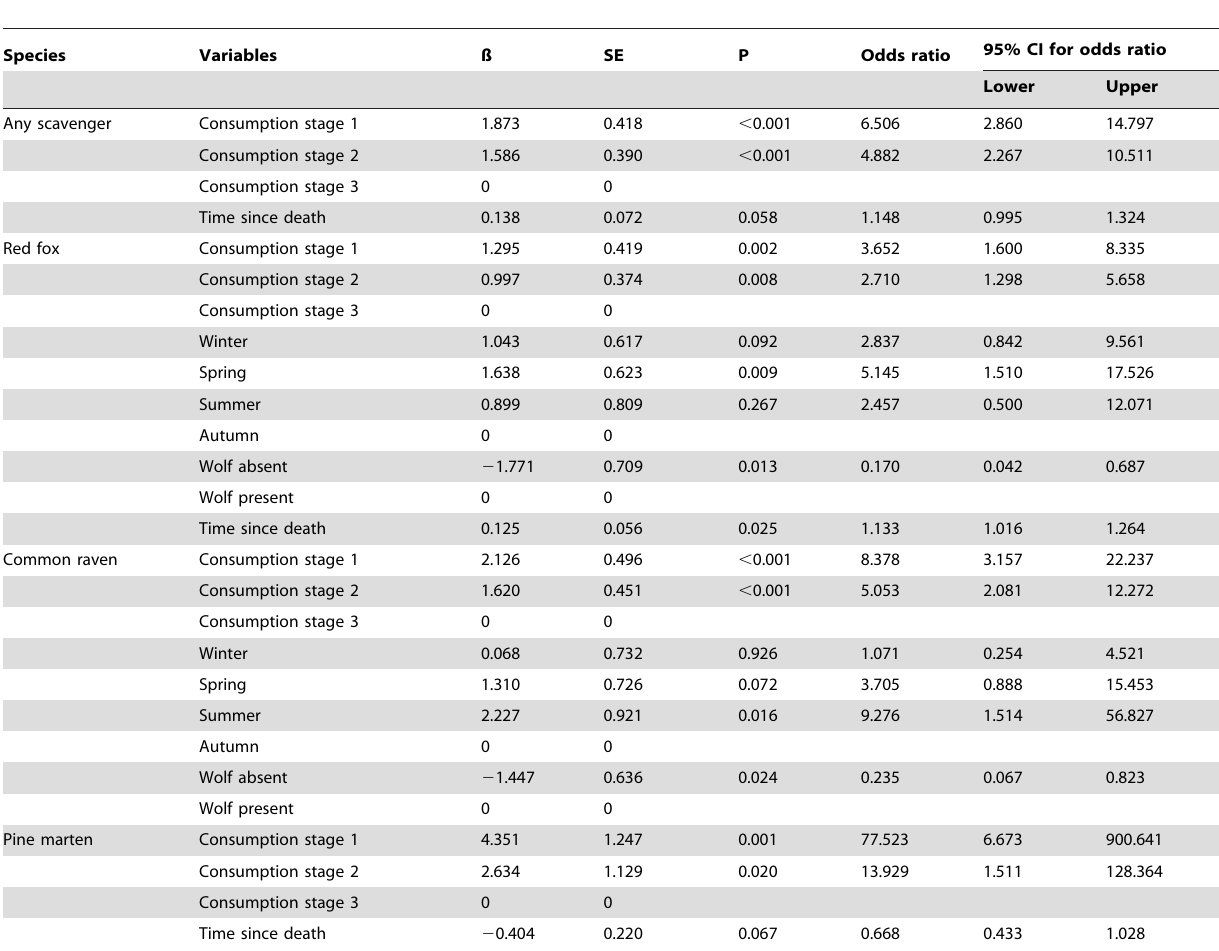
Table 3. Parameter estimates (ß) of consumption stage, season of the year, presence of wolves, and time (10-day interval) since death of moose on presence/absence by scavenging species to wolf-killed moose (n= 49) during ten-day periods (n=321).